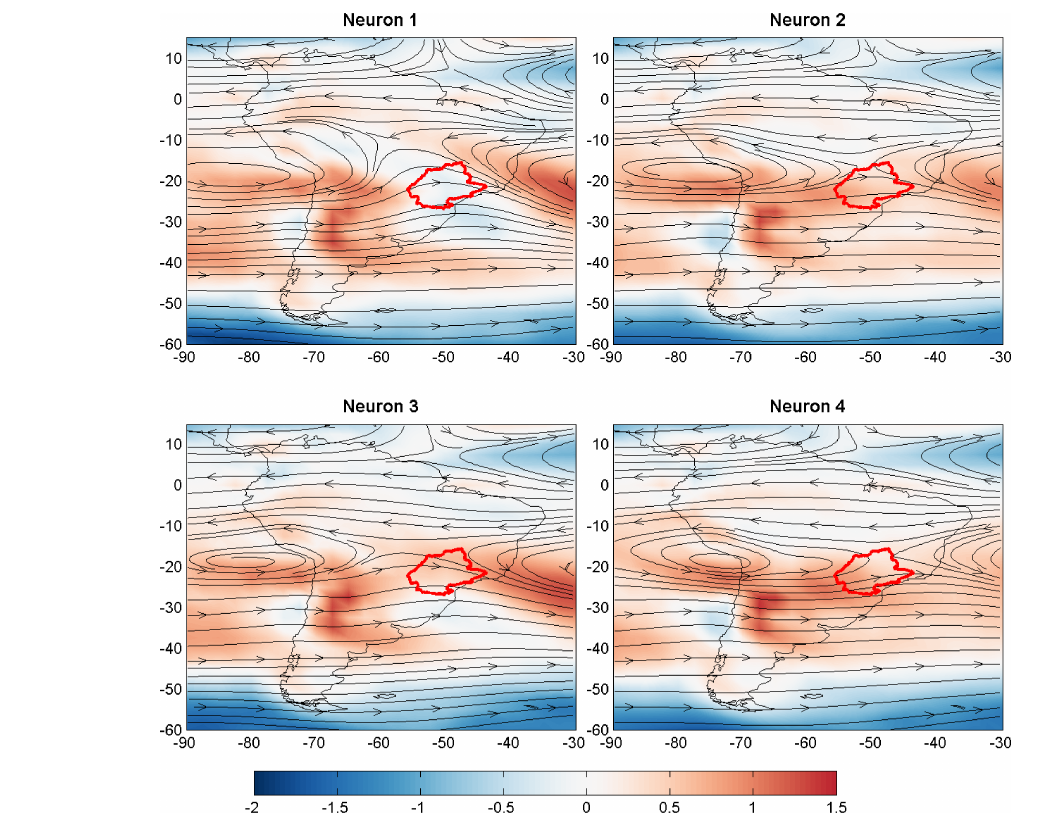
Figure 6. Streamlines for the high-level (500mbar) wind vector and relative vorticity (10 − 5 s − 1 ) averaged over each neuron class. The red contour line shows the Upper Paraná River